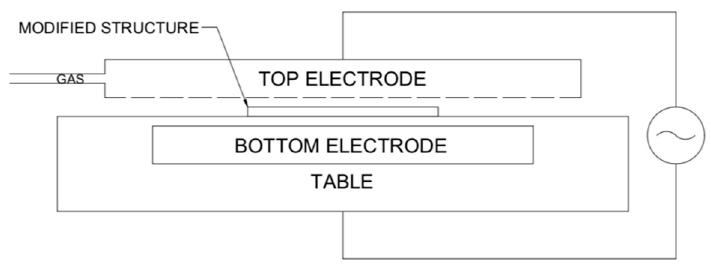
Figure 2. A schematic of the plasma modification reactor based on dielectric barrier discharge appearing between the bottom and top electrode under applied voltage. A modified structure is placed in between, with a working gas flowing through the top electrode.